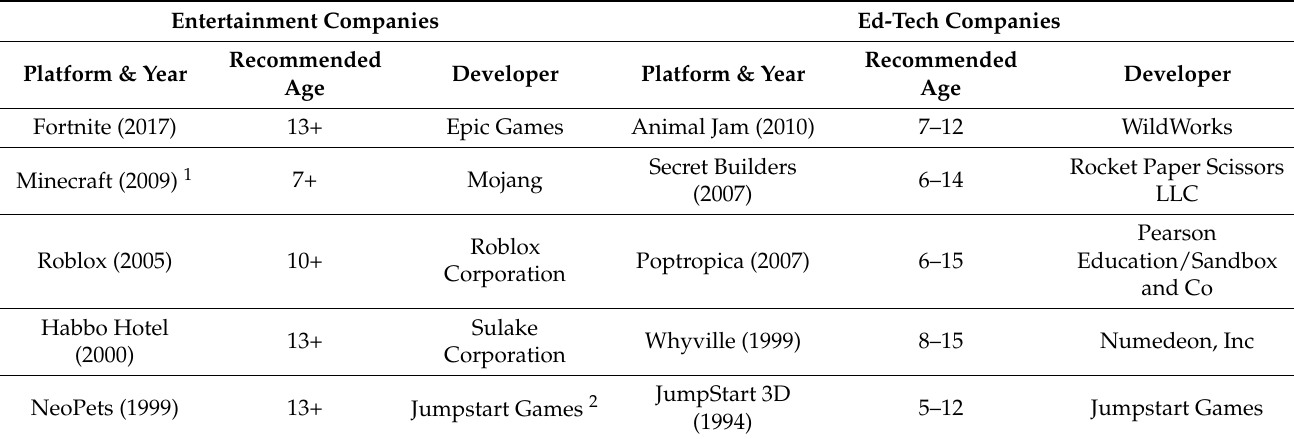
Table 2. Ten core VWs selected for detailed